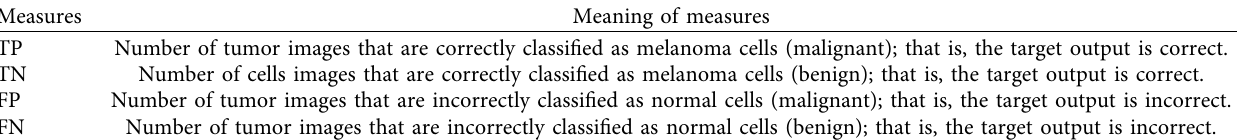
Table 3: The meanings of TP, TN, FP, and PN.